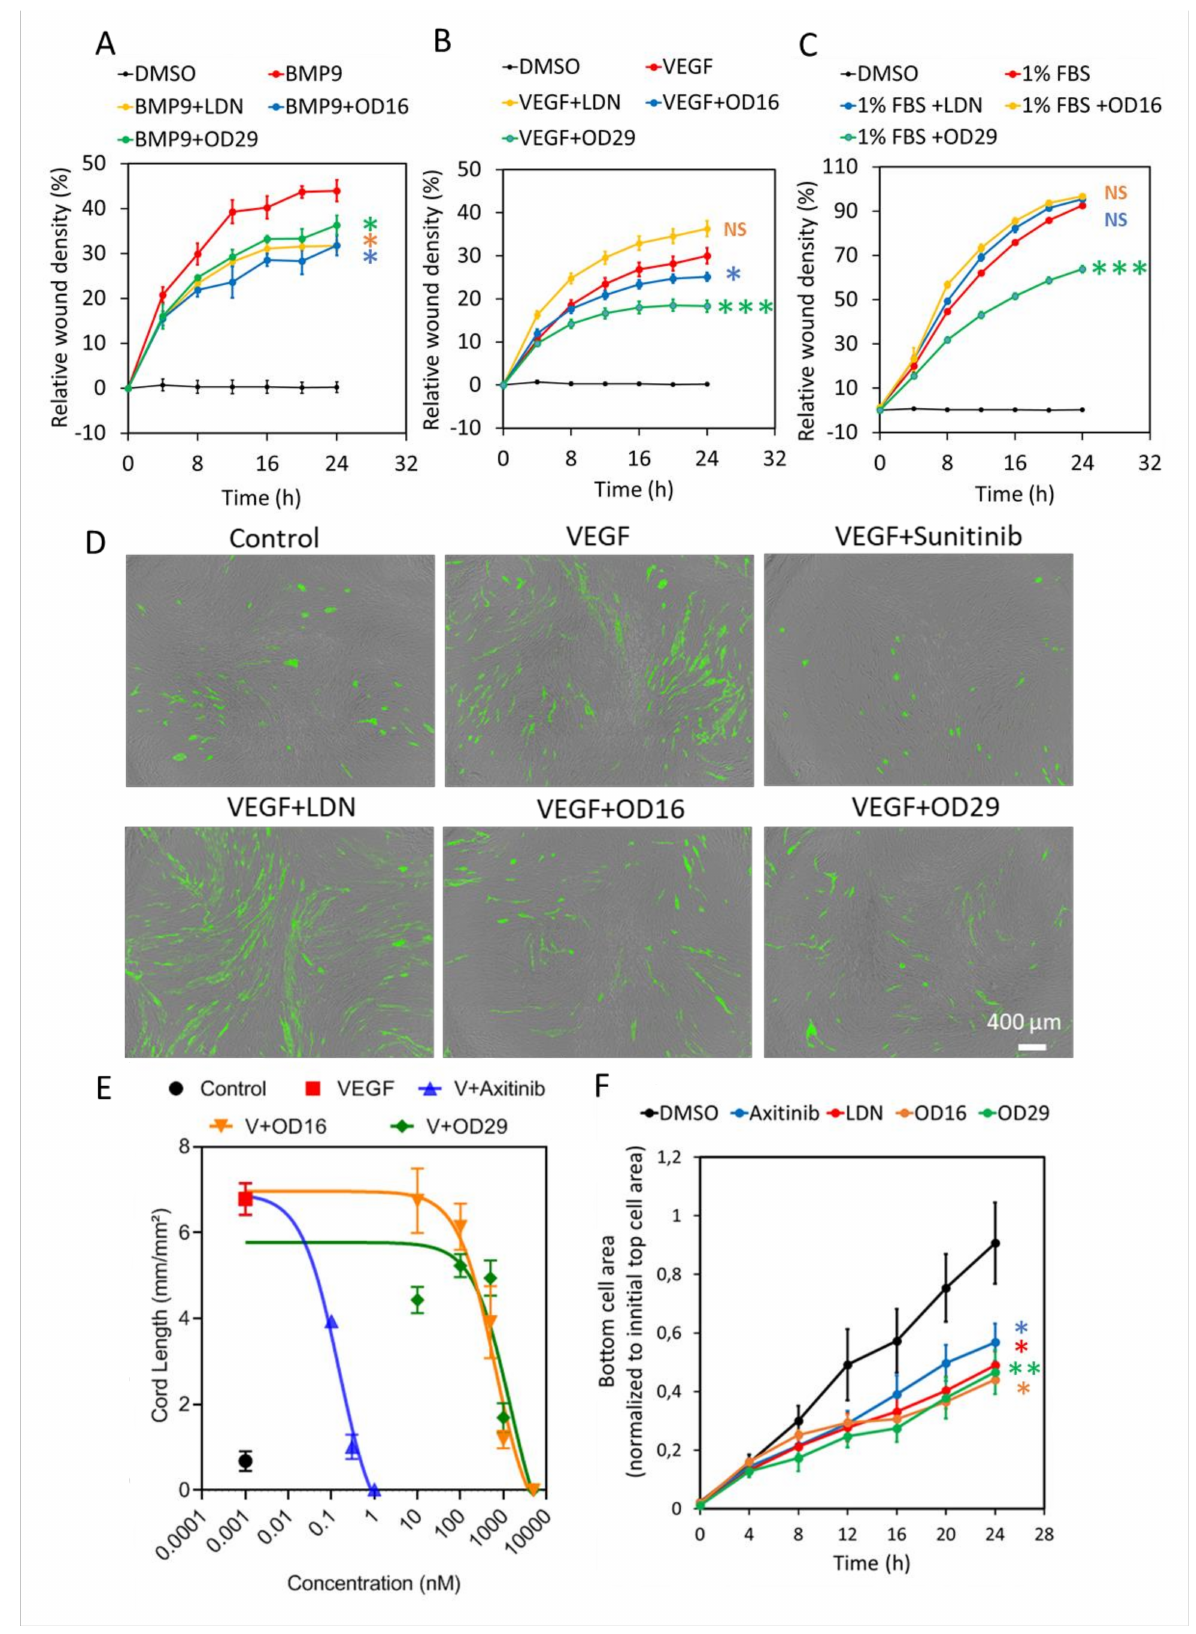
Figure 4. OD16 and OD29 attenuate EC migration, cord formation, and invasion in vitro. ( A – C ) Analysis of the real-time migration behavior of EA.hy926 cells exposed to ( A ) BMP9 (1 ng/mL), ( B ) VEGF (15 ng/mL), and ( C ) 1% FBS in the presence of vehicle control (DMSO), LDN-193189, OD16, or OD29 (0.5 µ M) within 24 h. Representative results from